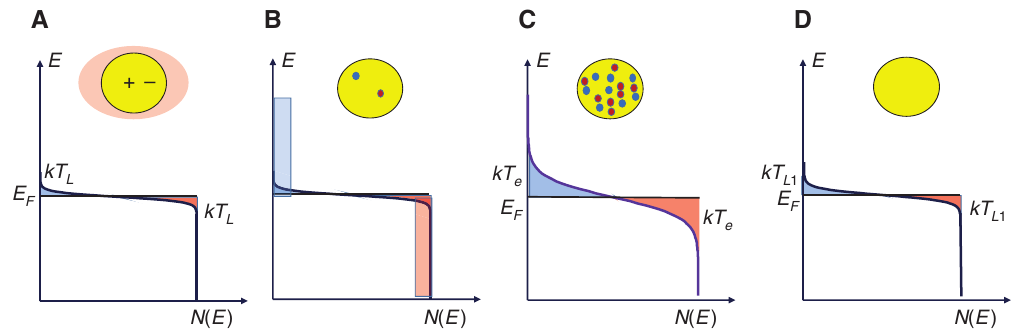
Figure 7: Conventionally assumed picture of hot carrier generation and relaxation in metal nanoparticles. (A) An SPP is excited on a nanoparticle while the carriers inside are distributed according to Fermi-Dirac statistics with equilibrium lattice temperature T . (B) After the SPP lifetime τ , this SPP has decayed and, as a result, non-equilibrium electron-hole pairs with energies L SPP + h ω have been generated. (C) After the electron thermalization time commensurate with τ ranging from E − h ω to E F F > T are distributed according to Fermi-Dirac statistics with electron temperature T . (D) After the electron-lattice thermalization time τ e L > T the electron and lattice are at equilibrium with a new lattice temperature T . This temperature will eventually decrease back to the L 1 L equilibrium lattice temperature T after time τ determined by the nanoparticle L L